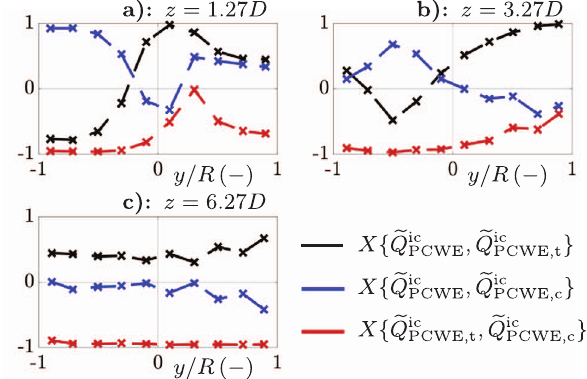
Figure 11. Cross-correlation pro fi les of the PCWE source terms and its components along the y -axis for case C 1 at positions (a) z = 1.27 D , (b) 3.27 D and (c) 6.27 D .